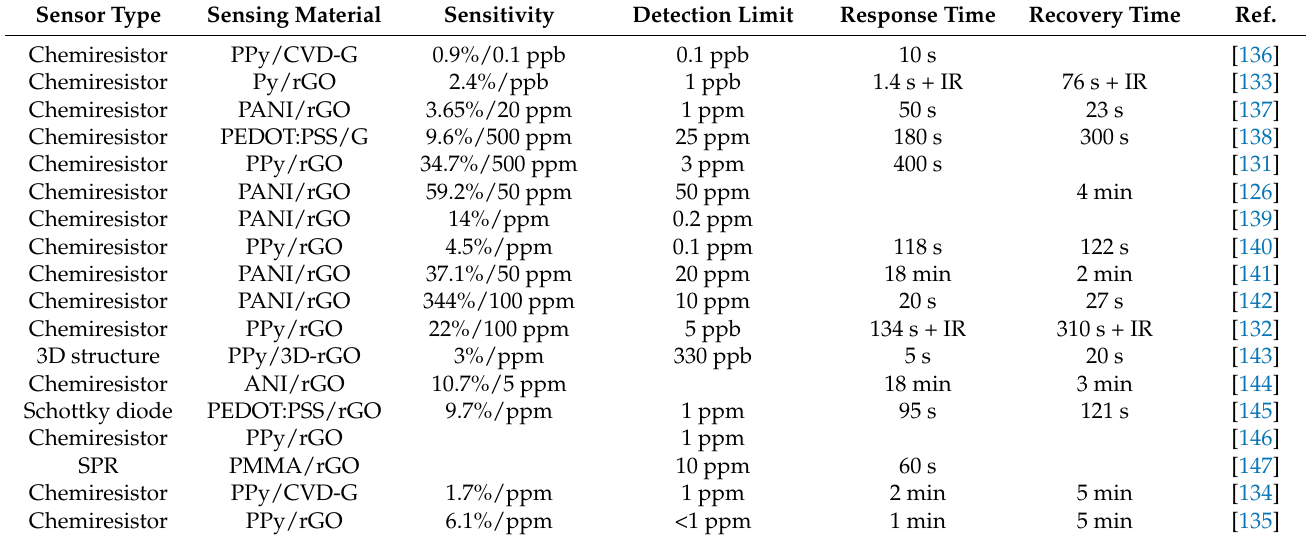
rGO: reduced graphene oxide, G: graphene, PPD: p-phenyldiamine, DMMP: dimethyl methyl phosphonate, PANI: polyaniline, ANI: aniline, Py: pyrrole, COP: chemical oxidative polymerization, PEDOT: PSS poly (3,4-ethylenedioxythiophene): poly (styrene sulfonate), IR: infrared light, SPR: surface plasmon resonance.